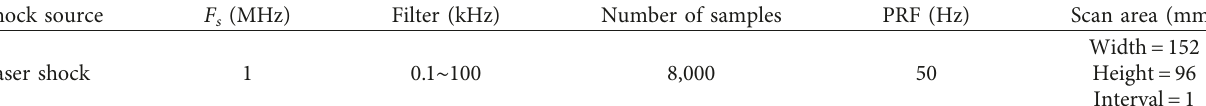
Table 2: Measurement conditions of laser scanning for simulation of pyroshock on the open-box-type tension joint. Shock source